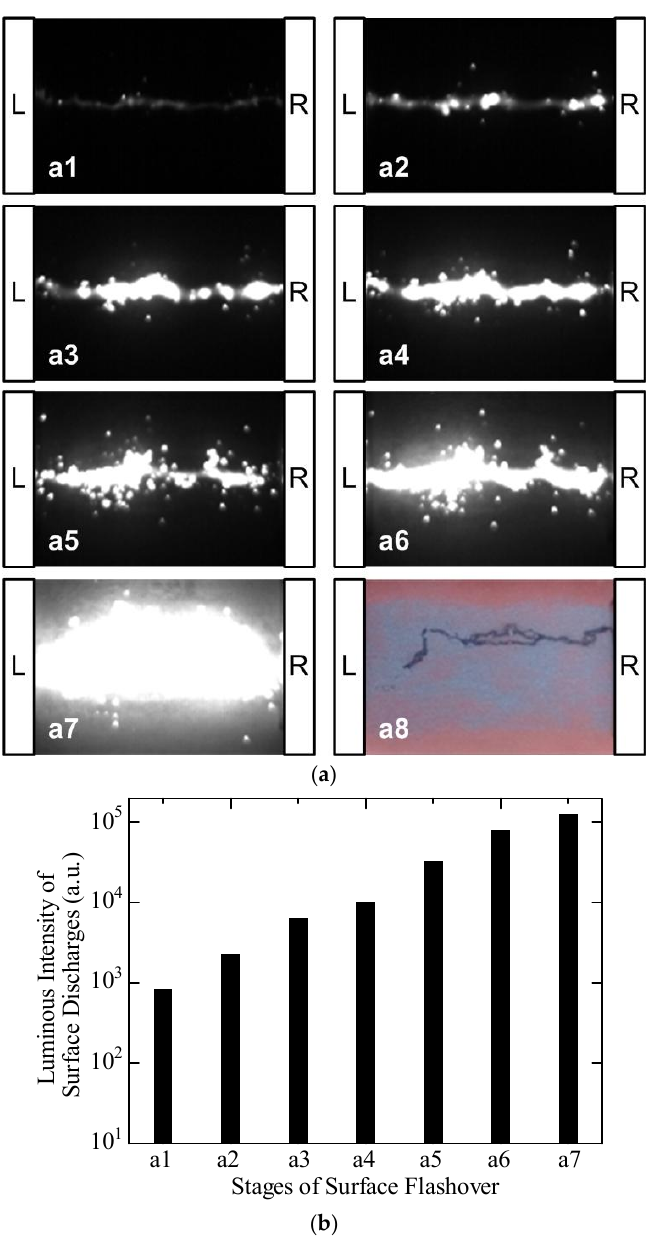
Figure 4. Process and luminous intensity of surface flashover in presence of fine particles (uniform distribution, particle size and amount of 24 μ m and 30 mg). ( a ) Process of surface flashover (L ‐ HV electrode, R ‐ grounded electrode); ( b ) Luminous intensity of surface discharges during the flashover.